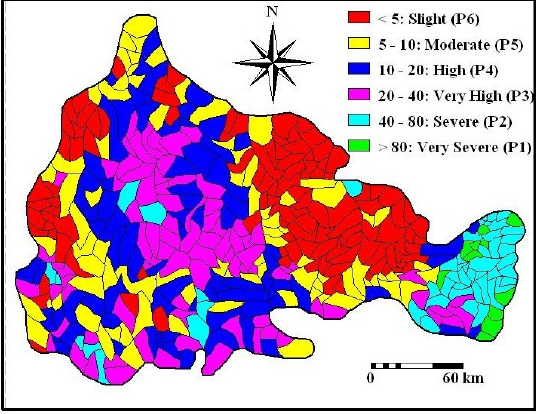
Figure 4. Prioritization Map of Different Sub-Watersheds in the Indravathi Basin Indravathi basin according to soil loss intensity. From the analysis, it is observed that the number of watersheds falls in first priority zone (i.e., very severe erosion class; P1) is 11. It is evident from analysis that the number of watersheds falls in P2, P3, P4, P5, P6 zones are 50, 85, 81, 82, and 115 respectively. Table 3. Computed and observed values (CWC, India) of sediment yield All sub-watersheds in first priority zone (P1) are found in upstream of the basin and the total soil loss from these sub- half of the Indravati catchment (54.26 %) falls under slight watersheds is 7.45 million tons. Most of the sub-watersheds in erosion risk class where soil loss is lower than 5 t h -1 y -1 (Table second priority zone (P2) are also found in upstream of the basin and the total soil loss from these sub-watersheds is 18.87 million tons. Overall analysis indicates that though the percentage of total area under these two zones is 9.88, but it contributes 35.52% of total soil loss in the basin. Therefore, it